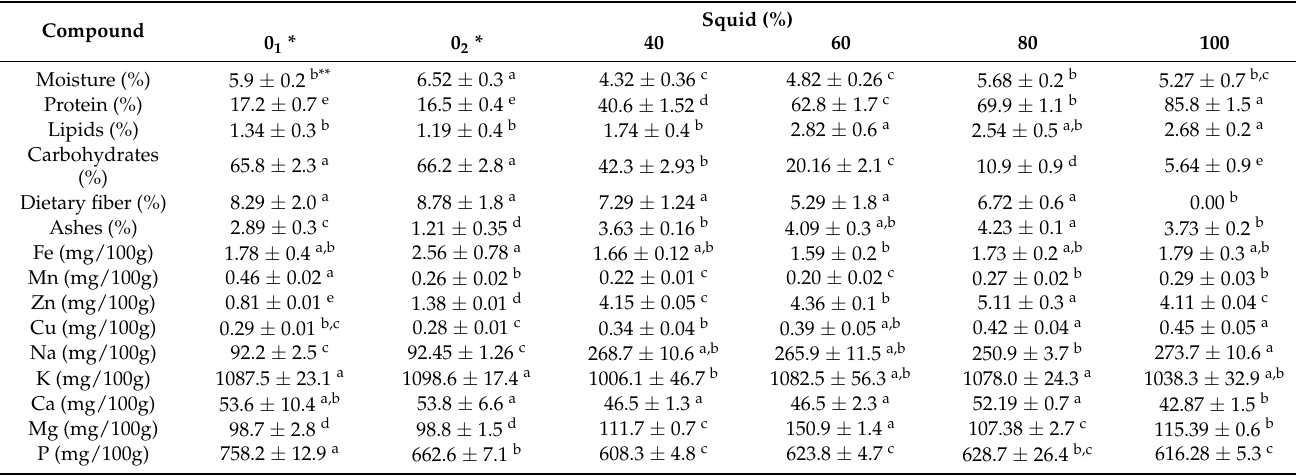
Table 1. Proximal composition and minerals (% dry base) of snacks expanded by extrusion with different levels of squid